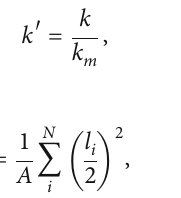
Figure 4: Fitted curves for the histograms of equivalent permeability regarding varied fracture geometric parameters l realizations. The blue, red, and green colors denote k xx , k yy , and k xy ,